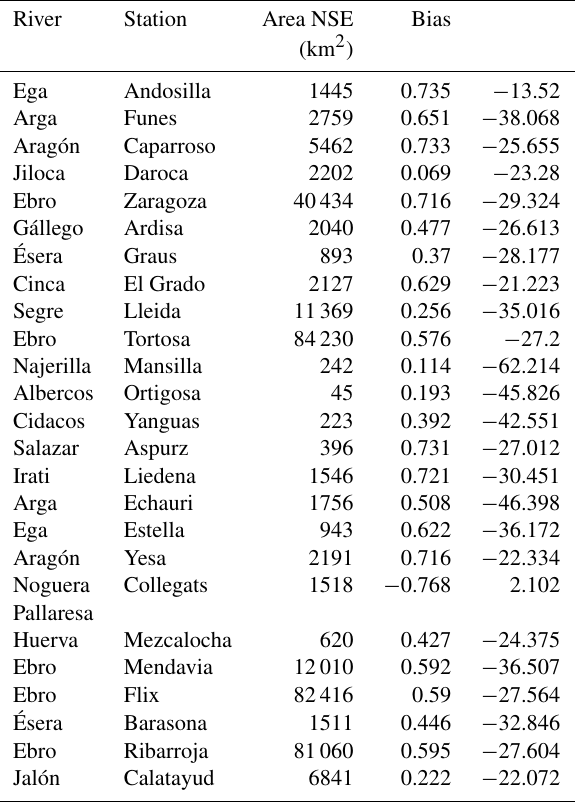
Table 1. The bias and NSE of high-resolution SAFRAN-SURFEX